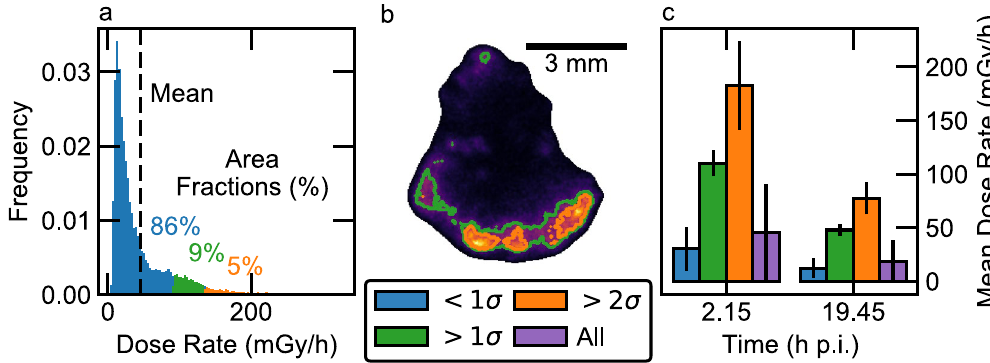
Figure 4. Uniformity analysis of instantaneous dose-rates at biopsy. ( a ) Dose-rate-area histogram of a slice of canine lymph node with regions segmented by deviation from the mean (dashed line). ( b ) Corresponding regions highlighted on the dose rate image in same colors. ( c ) Dose rates from two biopsies at different time points from the same canine. A mean value assessed over the whole organ underestimated the dose imparted to certain regions of tissue (5–6% of area) by a factor of